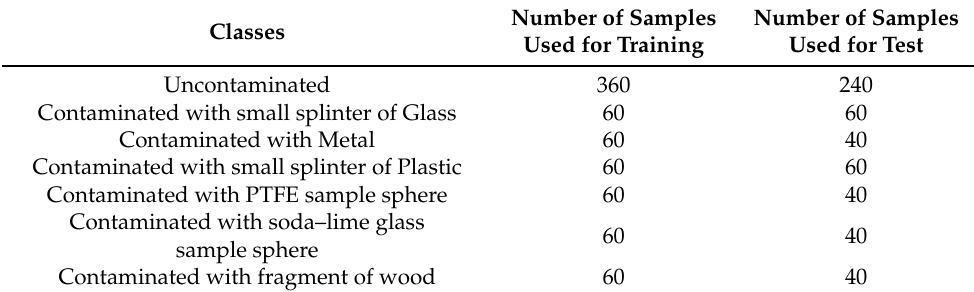
Table 1. Number of samples used from each class for training and test phases.